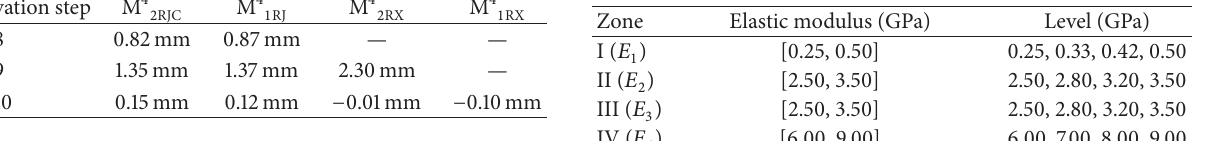
Table 2: Measured incremental displacement. Table 3: Elastic modulus levels of the four types of the slope rock